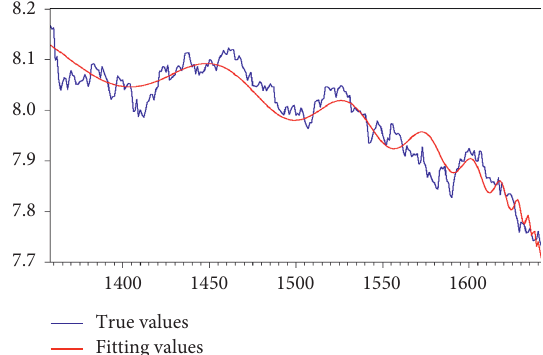
Figure 16: Fitting results from 2010/11 to 2011/12.